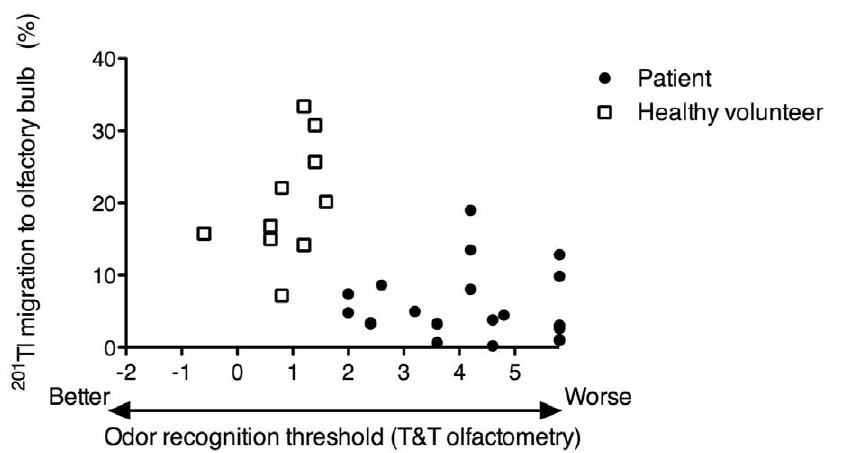
Figure 4. Correlation between olfactory 201 Tl migration and olfactory function as assessed by T&T olfactometry. Nasal 201 Tl migration to the olfactory bulb as a function of odor recognition threshold in patients and healthy volunteers (n=31). Spearman r =–0.62, P =0.0002. Closed circles, patients; Open squares, healthy volunteers.